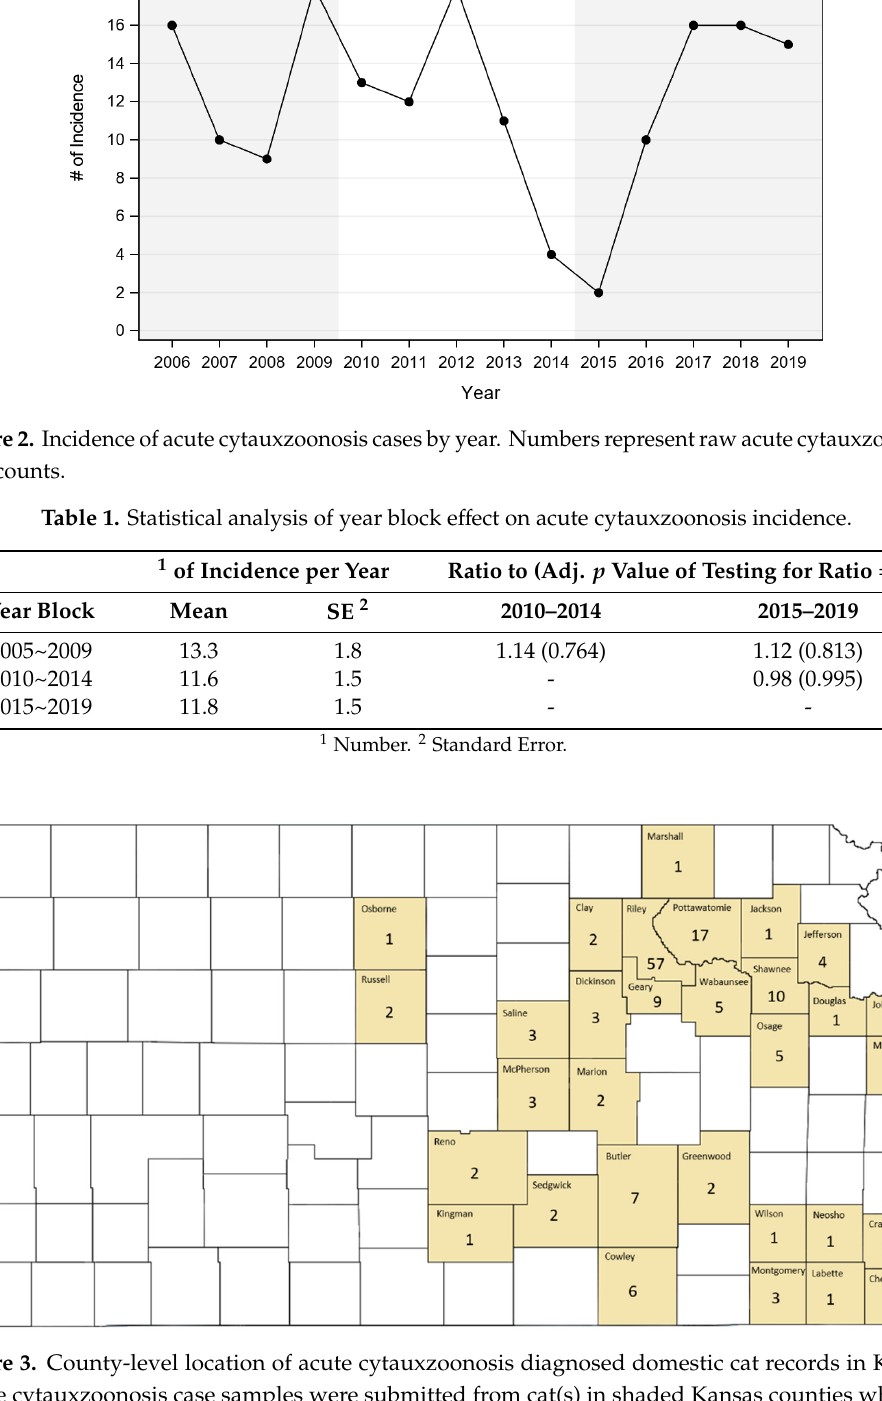
Figure 3. County-level location of acute cytauxzoonosis diagnosed domestic cat records in Kansas. Acute cytauxzoonosis case samples were submitted from cat(s) in shaded Kansas counties while no